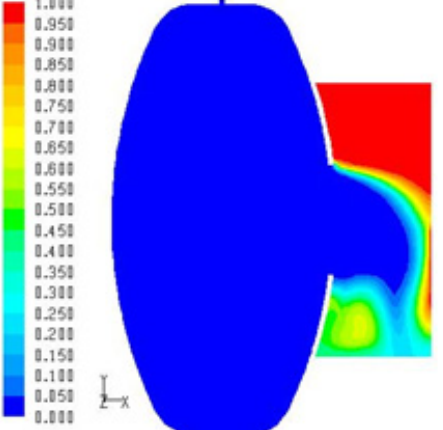
Fig. 3-5. Water level just over the upper edge of the chamber, the expressive rotating flow inside; outside it begins the transformation of gravitational flow into water splashing (spraying).